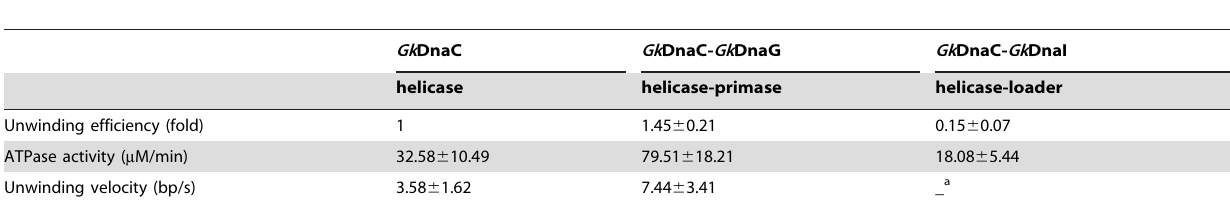
Table 3. Enzymatic activities of Gk DnaC, Gk DnaC- Gk DnaG complex and Gk DnaC- Gk DnaI